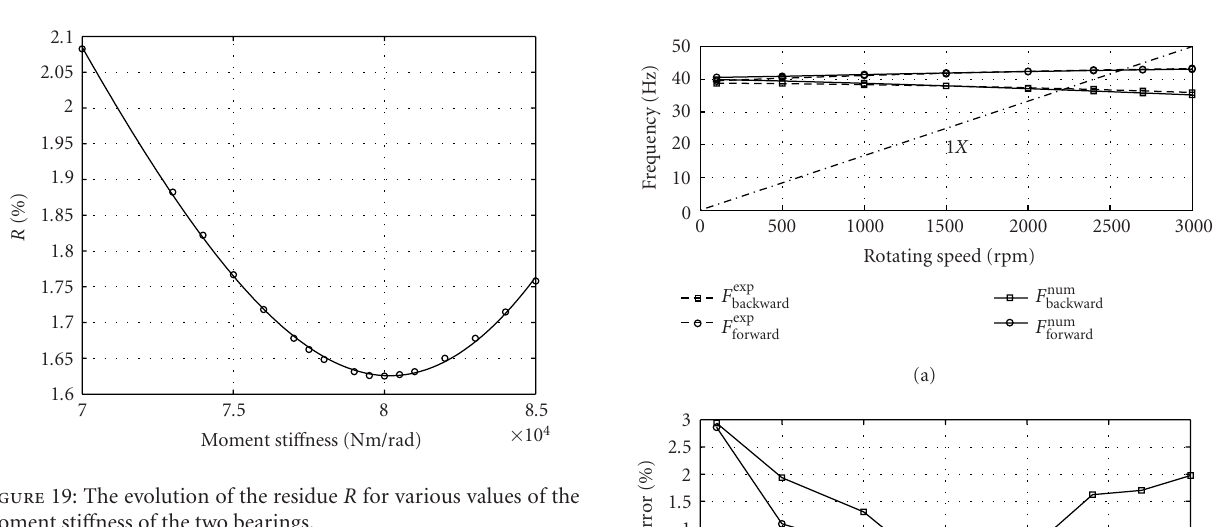
Figure 18: Finite element model of the rotor.